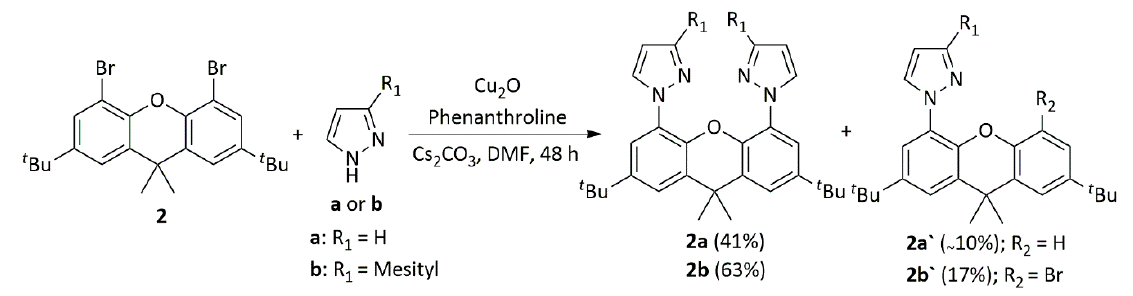
Scheme 2. Synthesis of pyrazolyl analogues of t Bu-Xantphos. Reaction conditions: Cu 2 O (10–20 mol%); phenanthroline (22–44 mol%); 2 (1.0 eq.); a or b (3.2 eq.); Cs 2 CO 3 (3.0 eq.); DMF (4 mL); 140–160 °C; 48 h.